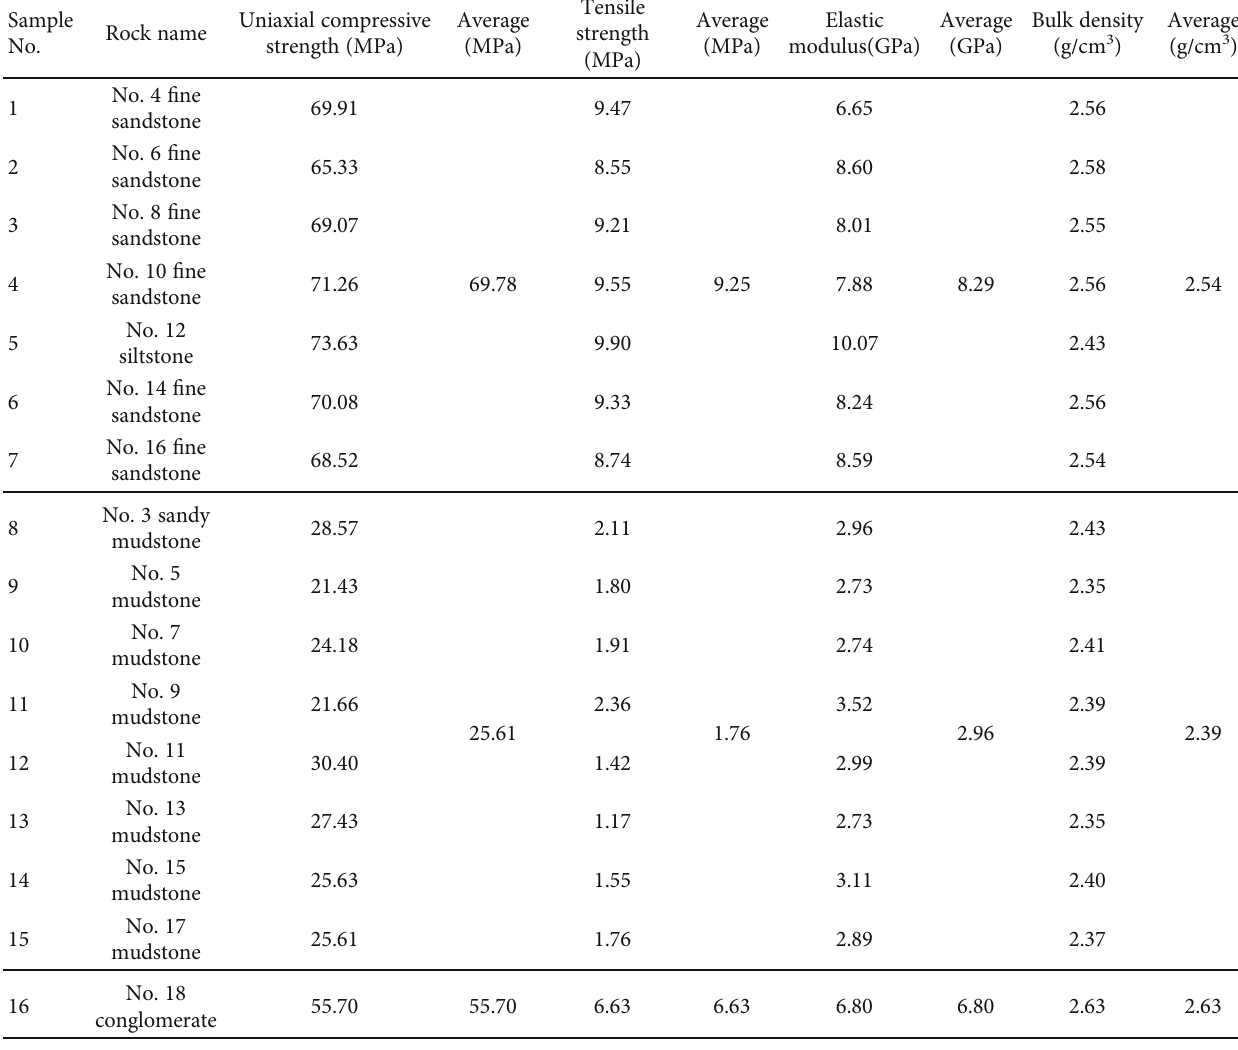
Table 1: Test results of physical and mechanical parameters.